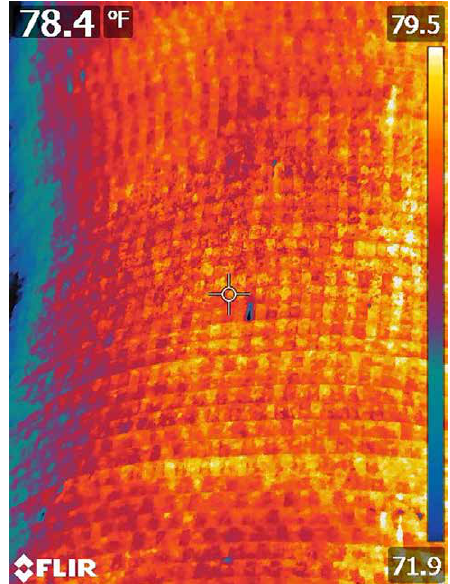
Figure 11. Thermal image of the north face of a cooling tower at Mitchell plant located in north-central West Virginia